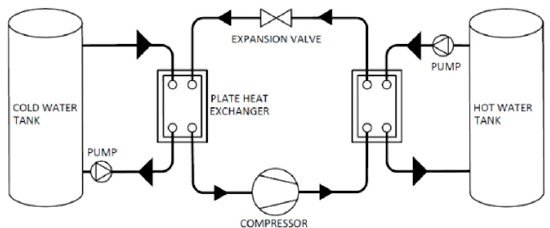
Figure 7. The schematic of the water-to-water heat pump.